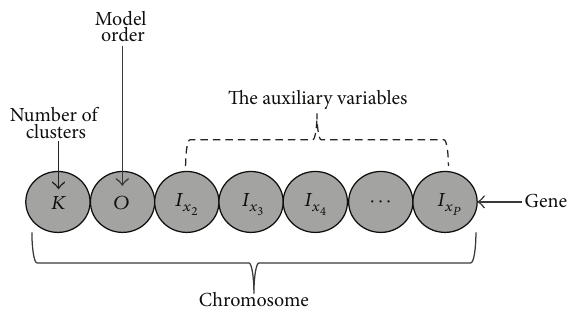
Figure 2: The component of chromosome in the proposed method.